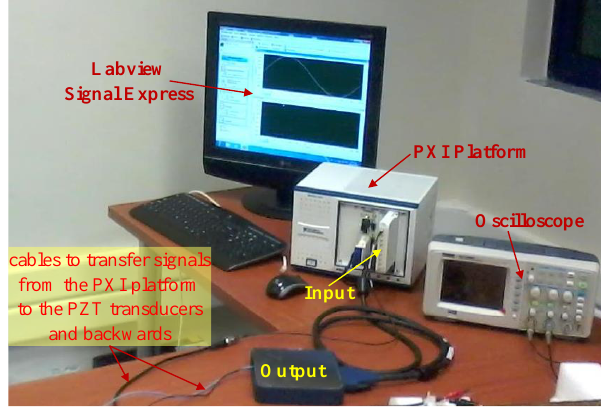
Figure 1. Test rig and instrumentation for the adopted Electro-Mechanical Admittance (EMA) method for damage detection using PZT transducers Figure 1: Test rig and instrumentation for the adopted Electro- Mechanical Admittance (EMA) method for damage detection using PZT transducers